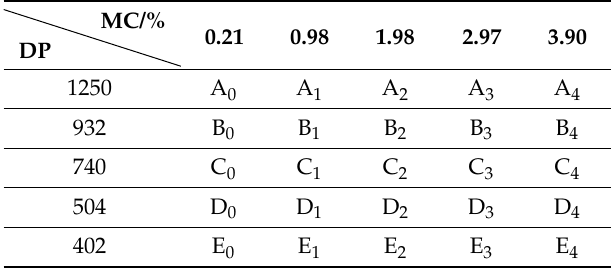
Table 2. Sample sets with different aging days and moisture